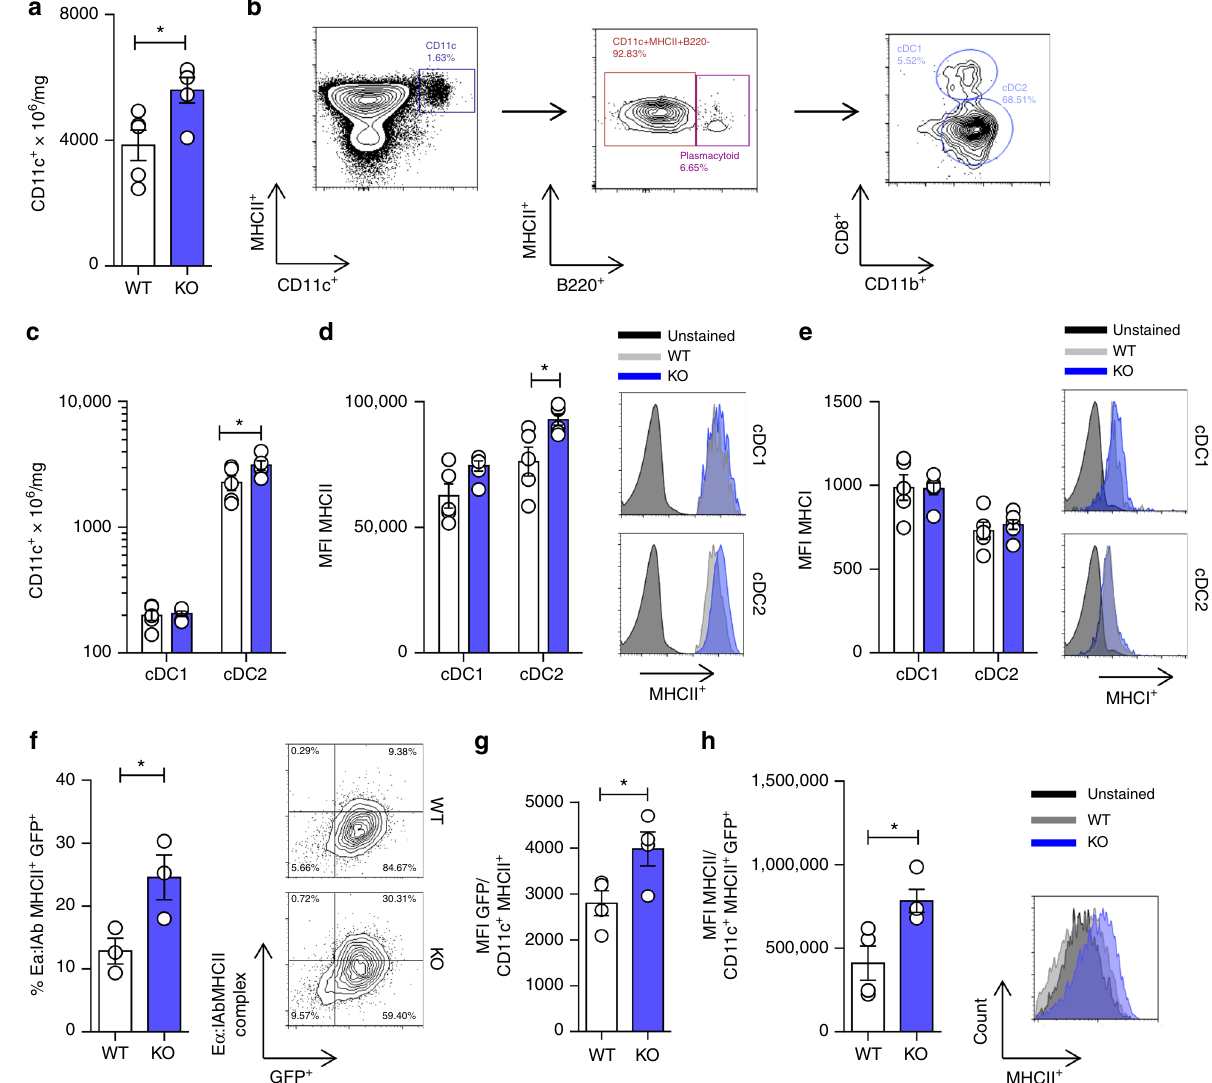
Fig. 4 ApoE de fi ciency alters the phenotype of spleen-derived DCs. a Number of CD11c + from WT and apoE KO spleen normalized by spleen weight. b Gating strategy for DC subsets phenotyping. c Number of cDC1 (CD11c + MHCII + B220 - CD11b − CD8 + ) and cDC2 (CD11c + MHCII + B220 − CD11b + CD8 − ) corrected for spleen weight of WT or apoE KO mice. d Median fl uorescence intensity (MFI) of MHCII in cDC1s and cDC2s from WT or apoE KO mice; representative histograms are shown. e Median fl uorescence intensity (MFI) of MHCI in cDC1s and cDC2s from WT or apoE KO mice; representative histograms are shown. f Percentage of double positive GFP + /E α :I MHCII + BMDCs after in vitro antigen uptake and presentation assay with E α peptide; representative contour plots are shown. g - h Median fl uorescence intensity (MFI) of GFP ( h ) and MHCII ( i ) in DCs after in vivo antigen uptake and presentation assay with E α peptide; representative contour plots and histograms are presented. N = 3 ( f ), N = 4 ( g – h ), N = 5 ( a – e ) per group. Statistical analysis was performed with unpaired T -test. Data are reported as mean ± SEM; * p <